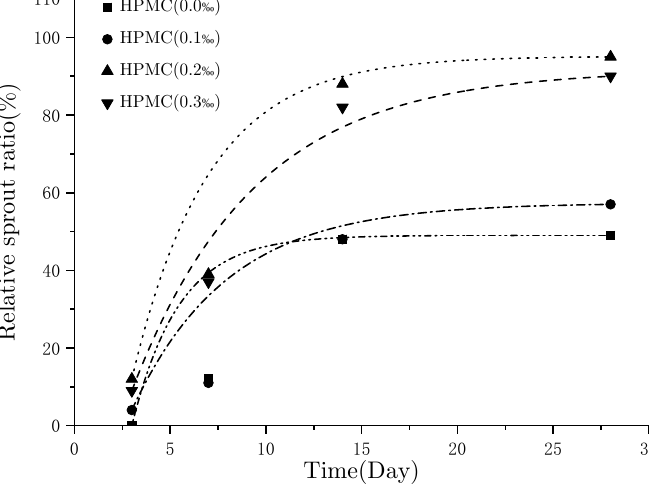
Figure 8. Curves of relative emerged versus time.